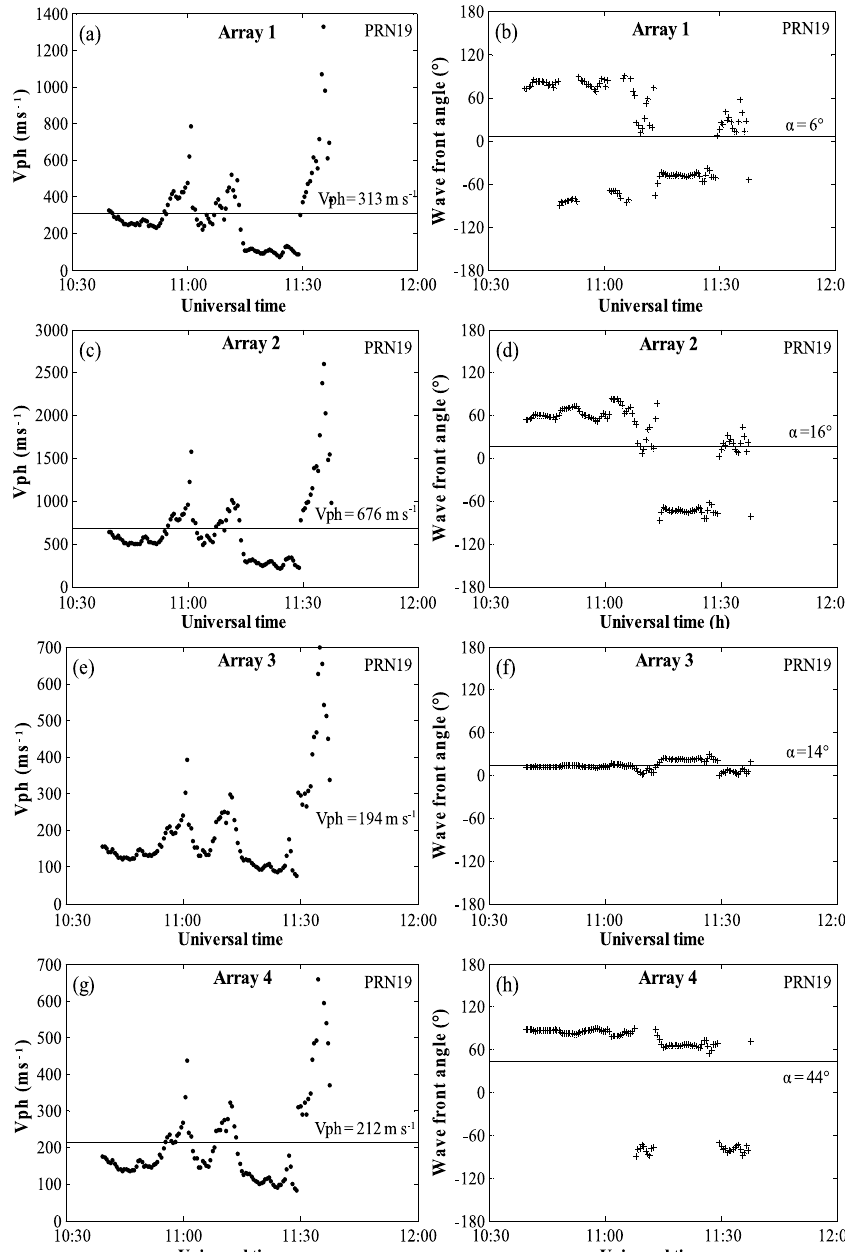
Figure 7. The characteristics of ionospheric disturbances for PRN 19 satellite on 17 March 2015 for four GPS arrays.